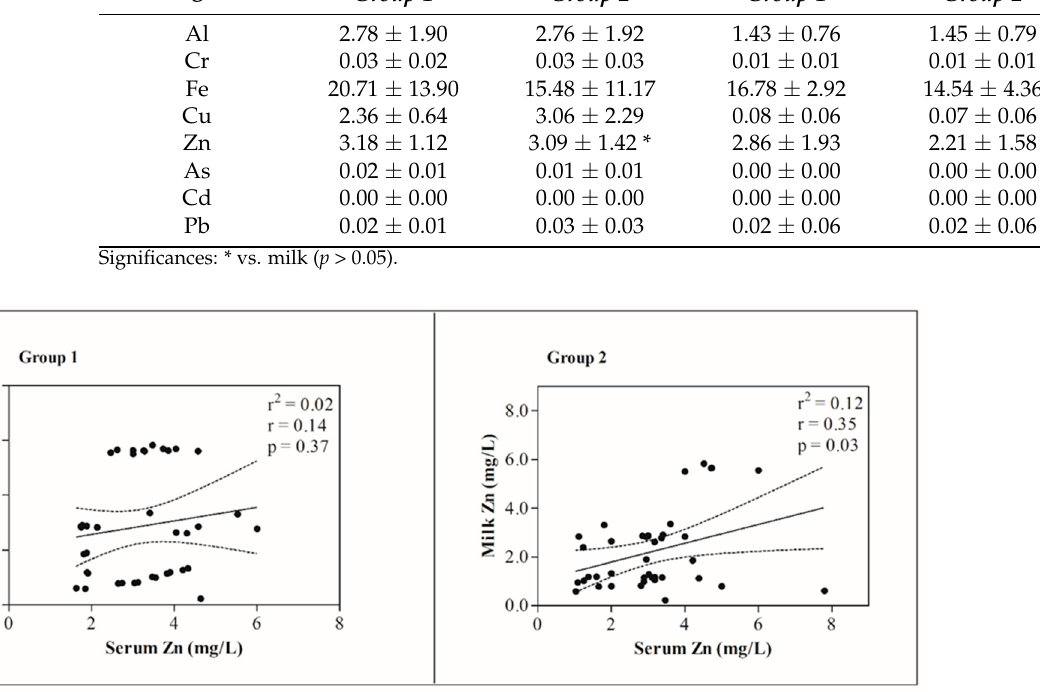
Figure 2. Linear regression values between the concentration of Zn measured in milk and serum samples obtained from 40 Friesian dairy cows housed in farm 1 at about 3.7 km form an industrial area (group 1) and 40 Friesian dairy cows housed in farm 2 at about 400 mt from a greenhouse and 6.0 km from a chemical fertilizer factory (group 2).